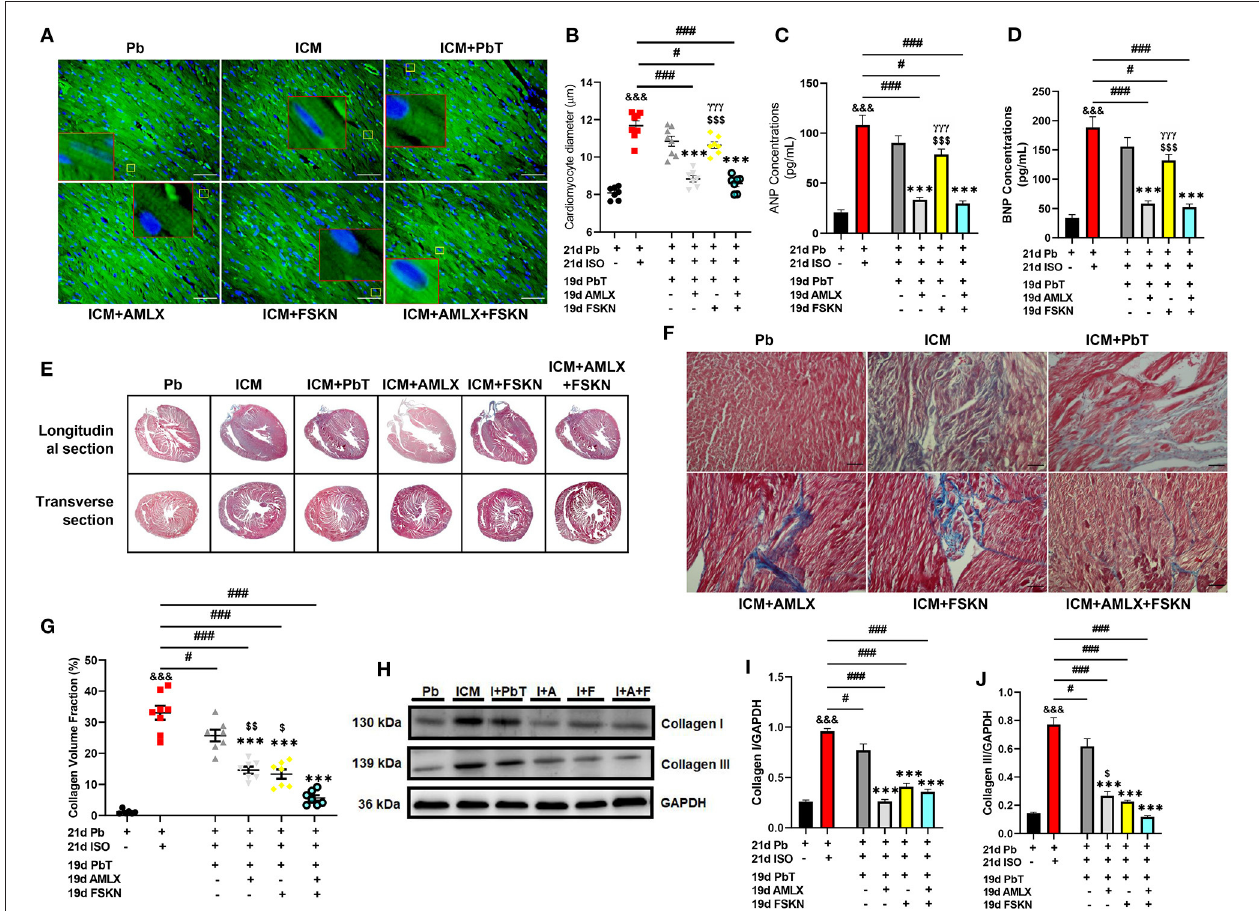
FIGURE 3 | Amlexanox and Forskolin attenuates isoproterenol-induced maladaptive cardiac hypertrophy and promotes fibrosis resolution. (A,B) Representative wheat germ agglutinin (WGA) merged with DAPI staining and graphical presentations of measured cardiomyocyte diameter from all treatment groups ( n = 10–12 cells per 5 field of view per 5 sections per 6–8 hearts per group). Representative cardiomyocytes are outlined in yellow boxes, and their zoomed-in (7x) inserts to show hypertrophy are outlined in red boxes. (C,D) Graphical plots of ELISA evaluations of cardiac hypertrophy markers (ANP and BNP, respectively), from obtained myocardial lysate. The ELISA were performed in triplicates ( n = 6–8 mice per treatment group). (E,F) Representative Masson’s trichrome stained longitudinal and transverse sections with detailed microscopic images showing interstitial collagen deposition. (G) Graphical plots collagen volume fraction from all groups ( n = 6–8 field of view per 5–7 sections per 6–8 hearts per group). (H–J) Representative immunoblots and graphical presentations of Collagen I and Collagen III from Pb; placebo, ICM; isoproterenol-induced cardiomyopathy, I + PbT; ICM + placebo treatment, I + A; ICM + AMLX treatment, I + F; ICM + FSKN treatment and I + A + F;